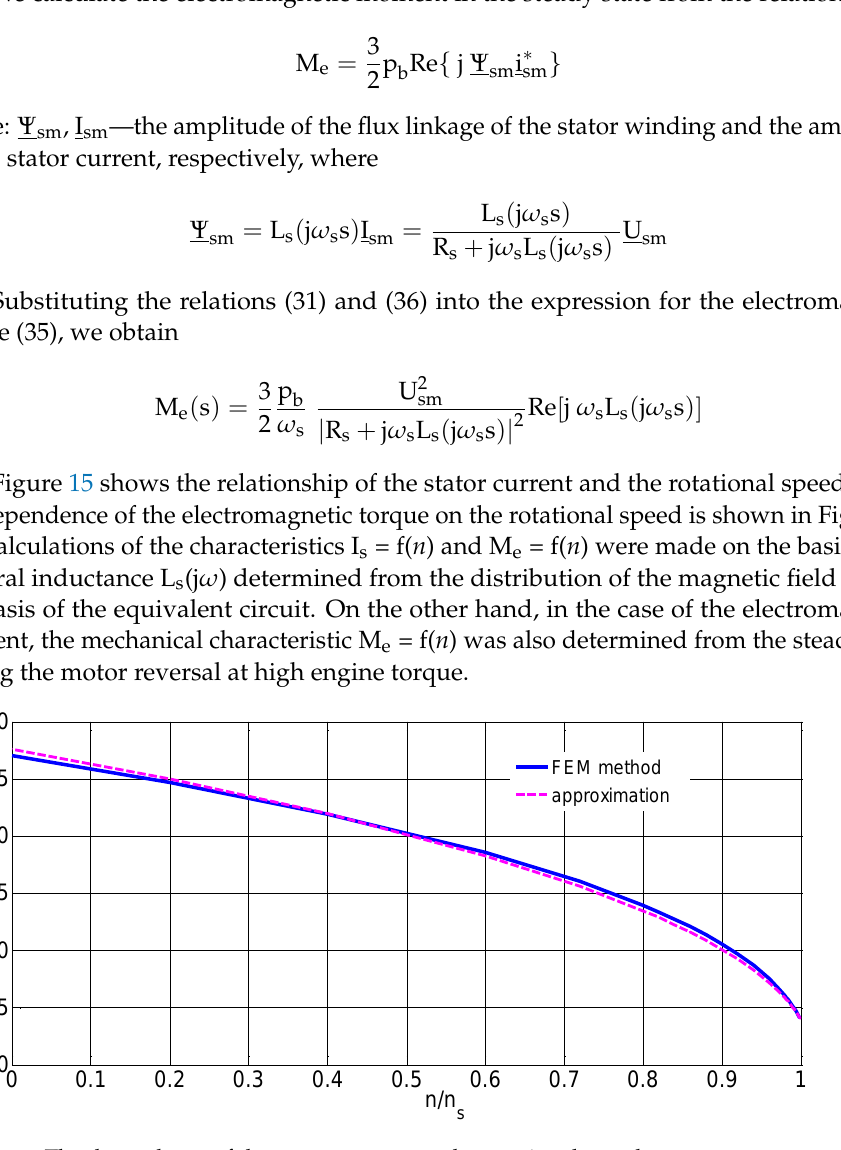
Figure 16. Dependence of the electromagnetic torque on the rotational speed. The comparison of the characteristics presented in Figures 15 and 16 shows a good agreement between the results calculated from the distribution of the magnetic field by the finite element method and the results obtained on the basis of the equivalent circuit, and in the case of the electromagnetic torque, with the results obtained from the transient state during the motor reversal. It proves the correct identification of the equivalent circuit parameters and the correctness of the calculation of the dynamic states of the induction motor with a solid rotor. 6. Conclusions The transient analysis of solid-rotor induction machines can be conveniently per- formed in the d, q rotor reference frame (by utilizing Park’s transform) because then the rotation voltage is absent in the equivalent circuit of the rotor circuit. Therefore, the solu- tion of differential equations containing fractional-order derivatives is simplified. The use of a fractional-order operator impedance in the equivalent circuit of the rotor, which is a series combination of resistance and inductance with constant values and the fractional- order inductance, allows for a more accurate representation of the skin effect in a solid rotor. The frequency method presented in this paper, based on the calculation of the spec- tral inductance by the finite element method in a large frequency range, is particularly useful for determining the parameters of higher-order models and models with fractional impedance of the rotor. This method also makes it possible to take into account the satu- ration of the magnetic circuit of the machine and does not require the use of an extra drive motor. However, determining the parameters by this method in an experimental way en- counters significant difficulties related to carrying out measurements in the low-